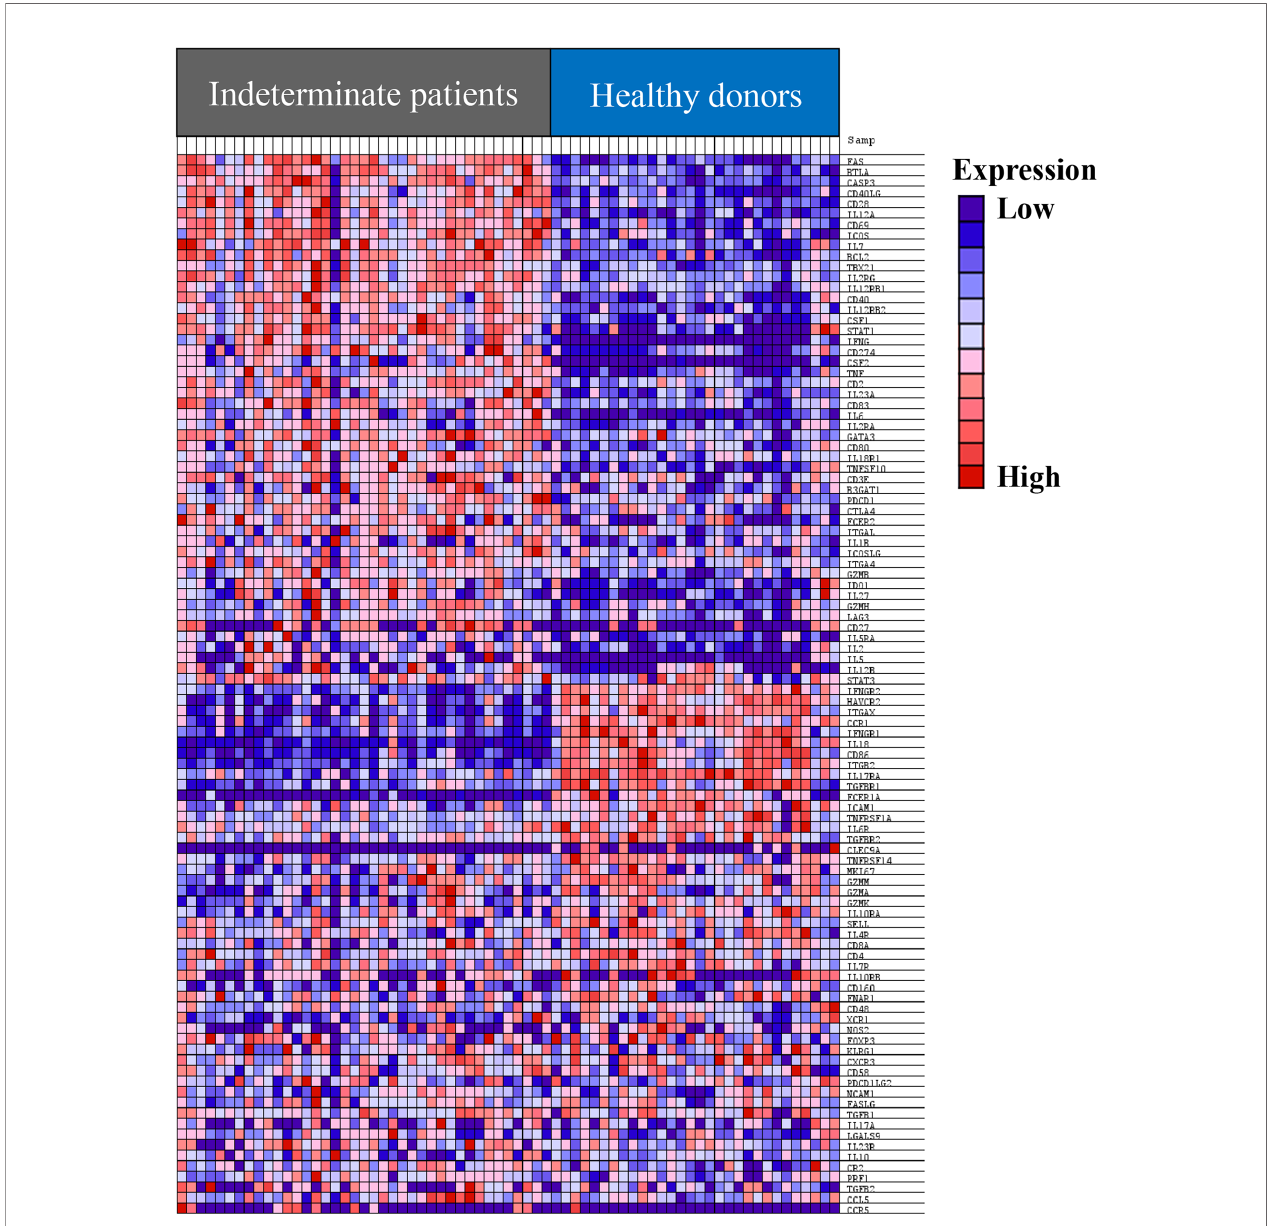
FIGURE 2 | Heat map of the top 100 genes determined by GSEA analysis in IND and HD subjects. The values of the gene expression level of each gene are represented as colors, ranging from dark red to dark blue, based on the highest and lowest normalized relative quantities (NRQ) values of each gene, respectively. The genes represented in vertical order from the top to the bottom are FAS , BTLA , CASP3 , CD40LG , CD28 , IL12A , CD69 , ICOS , IL7 , BCL2 , TBX21 , IL2RG , IL12RB1 , CD40 , IL12RB2 , CSF1 , STAT1 , IFNG , CD274 , CSF2 , TNF , CD2 , IL23A , CD83 , IL6 , IL2RA , GATA3 , CD80 , IL18R1 , TNFSF10 , CD3E , B3GAT1 , PDCD1